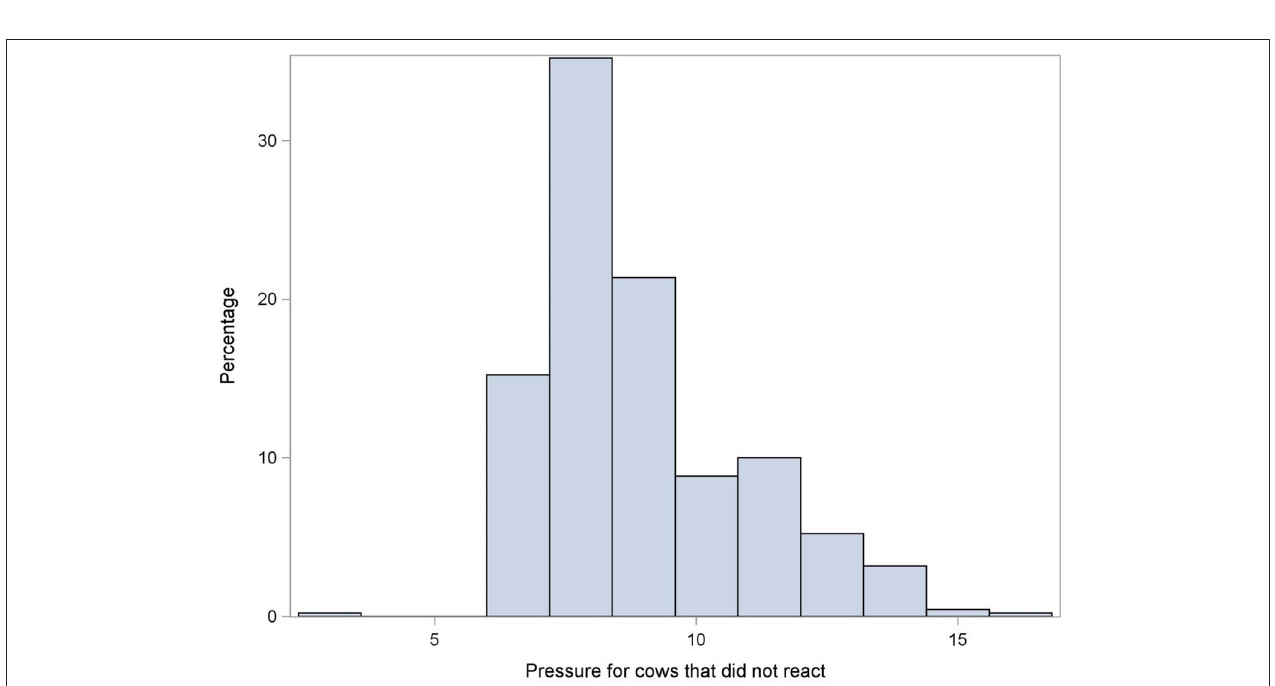
FIGURE 3 | Distribution of the amount of pressure applied using a handheld pressure algometer in cases where cows did not react (in kg; maximum pressure). Data obtained using one measure per day for five consecutive days on 36 milking cows. adjustment for multiple comparisons using the Tuckey-Kramer (among the 325 cow-observations that reacted). One rater adjustment, the effect of order of measurements on MNT was recorded MNT that were on average 0.63 kg (95% CI: 0.17, only significant between 2nd and 3rd measurements ( P = 1.10) higher than MNT recorded by the other rater. After